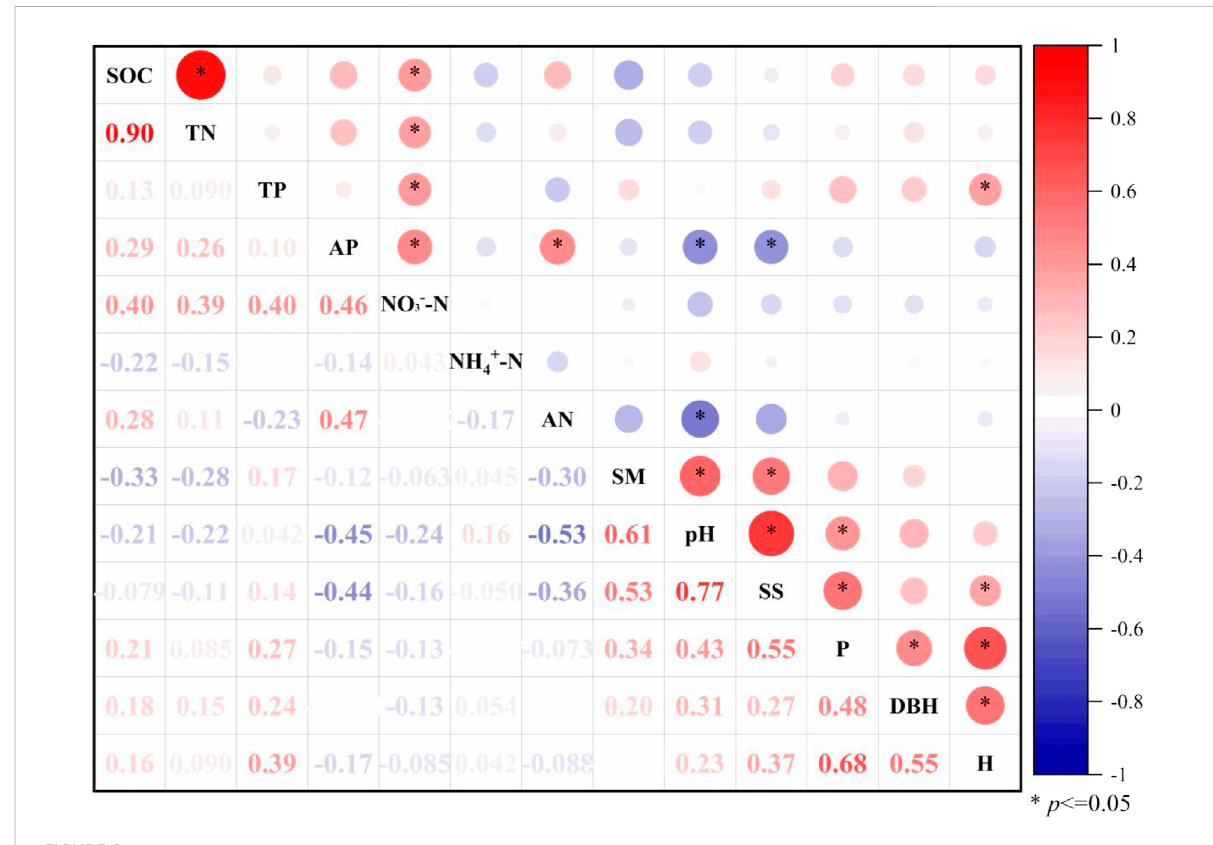
FIGURE 2 Correlation analysis of factors that in fl uence the ‘ fertilizer island ’ effect of different nutrient contents in Haloxylon ammodendron.